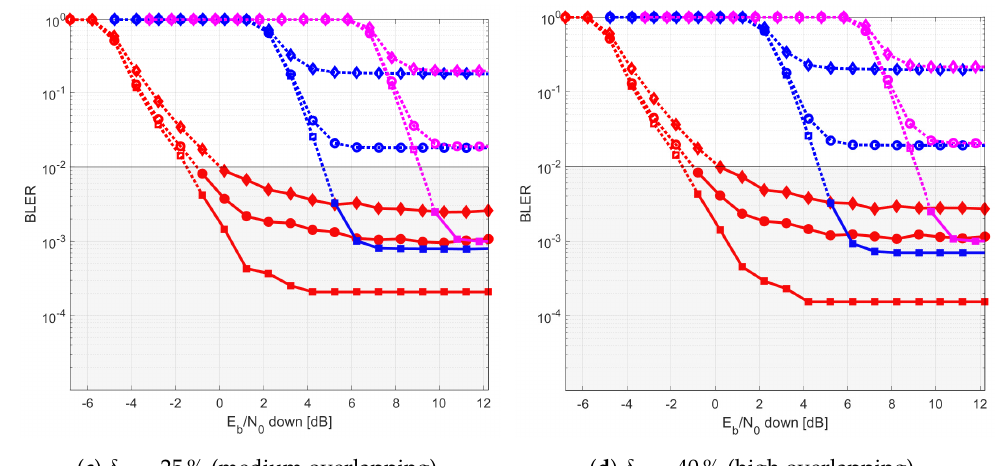
Figure 19. End-to-end BLER versus E b / N 0 in the access link for a NB-IoT frame encapsulated in a DVB-S2(X) regenerative satellite (SNR fl = 15dB). NB-IoT code rates: 1/3 (red), 2/3 (blue) and 0.96 (magenta). DVB-S2(X) code rates: 2/3 (squares), 0.8 (circles) and 0.9 (diamonds). Solid (dashed-) lines with (un)filled markers: BLER ≤ 10 − 2 requirement (not) fulfilled. Wind speed: v = 21m/s. Diameter of telescope aperture: W 0 =